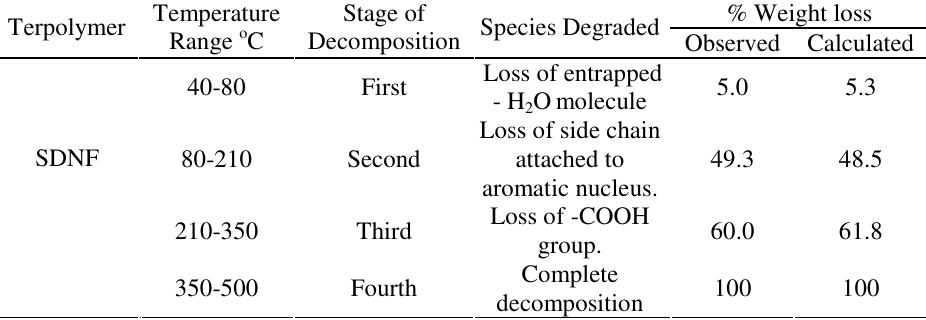
Table 1. Thermoanalytical data and decomposition temperature of SDNF terpolymer